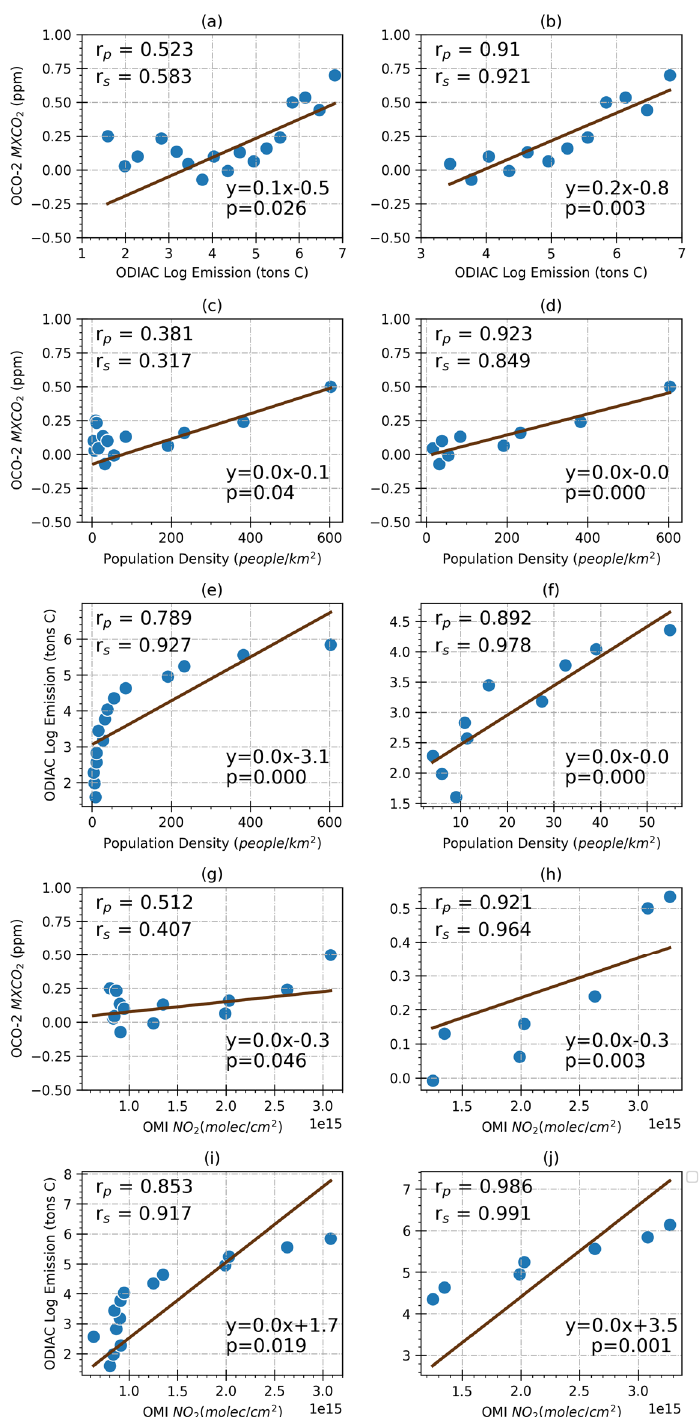
Figure 7. ( a ) Scatterplot between ODIAC and OCO-2 anomalies (MXCO 2 ), ( b ) scatterplot between ODIAC and OCO-2 anomalies at higher values, ( c ) scatterplot between OCO-2 and population density, ( d ) scatterplot between OCO-2 and population density at higher values, ( e ) scatterplot between ODIAC emissions and population density, ( f ) scatterplot between ODIAC emissions and population density at lower values, ( g ) scatterplot between OCO-2 and NO 2 tropospheric column, ( h ) scatterplot between OCO-2 and NO 2 tropospheric column at higher values, ( i ) scatterplot between ODIAC emissions and NO 2 tropospheric column, and ( j ) scatterplot between ODIAC and NO 2 tropospheric column at higher values. The Pearson and the Spearman correlations are represented by r p and r s , respectively.